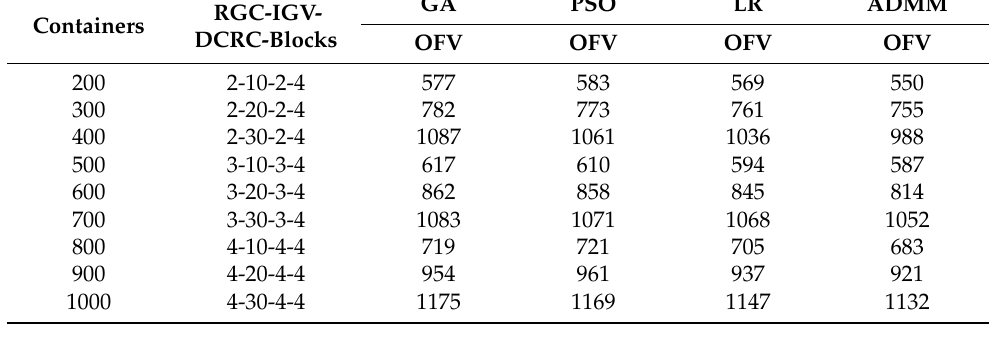
25 of 28 Figure 11. Heat map of the walking path of the horizontal IGV formation. 5.4. Discussion This paper studies the multi-equipment cluster scheduling, which is benificial to improving the collaborative processing and continuity of terminal equipment, and improve the efficiency of automated terminal and sea–rail combined transportation. However, most studies on multi-device scheduling only consider the coordination between devices [18,19,21–23,26] or additionally consider other goals as constraints [20,24,25]. More scholars are building mixed-integer programming models, and heuristics are mentioned more when solving models [21,22,25,26] by comparing genetic algorithms (GA) [21], particle swarm optimization (PSO) algorithms [26], and LR to verify the ability of ADMM algorithms to solve large problems. The volume of tasks for setting up containers varies from 200 to 1000. The experimental results are shown in Table 6. Table 6. OFV calculated by GA, PSO, LR, and ADMM. Containers